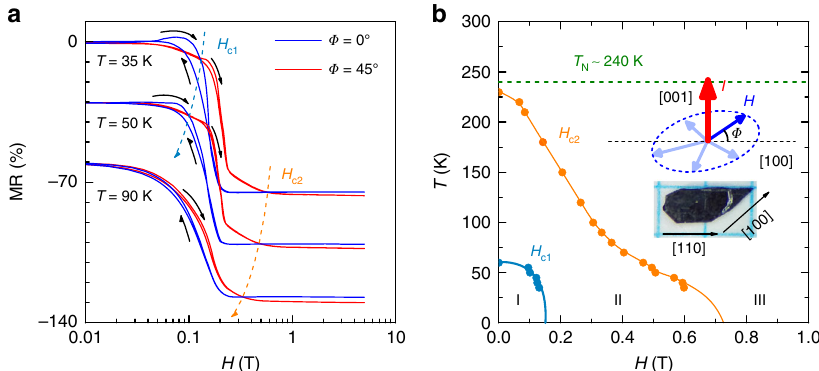
Fig. 1 Magnetotransport in Sr 2 IrO 4 single crystal. a Measured magnetoresistance as a function of H applied at Φ = 0 o and Φ = 45 o at T = 35 K, 50 K, and 90 K. The intercross points indicated by blue ( H c1 ) and orange ( H c2 ) dashed lines are used for building up the phase diagram. The H -sweeping directions are indicated by black arrows. For a better version, the curves have been shifted vertically. b Phase diagram of the anisotropic magneto-transport in Sr 2 IrO 4 single crystal. The inset: the measurement geometry and two major crystalline directions of the crystal